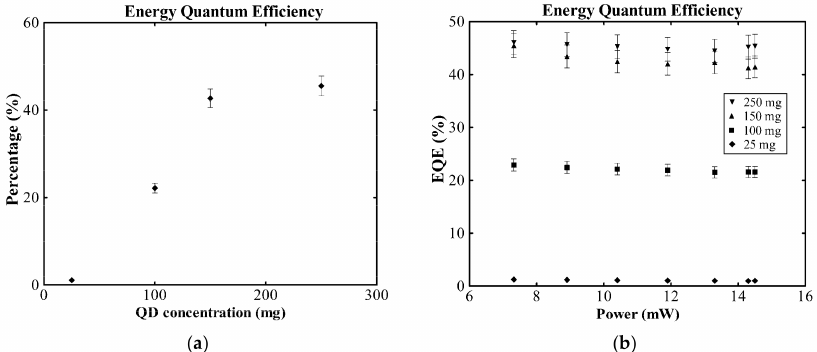
Figure 9. ( a ) The variation of the energy quantum e ffi ciency (EQE) by increasing the concentration of the QDs in the compound films and ( b ) the variation of EQE by increasing the power of the incident UV